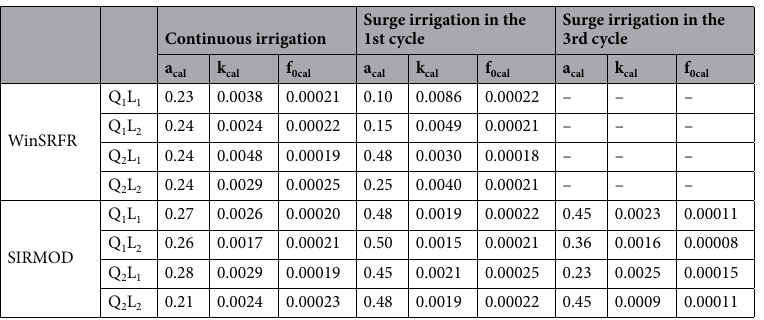
Table 4. Calibrated values of the non-conservatives infiltration parameters of the continuous and surge irrigations in WinSRFR and SIRMOD. Q: stream size; L: furrow length; R 0.5 : surge irrigation with cycle ratio of 0.5. k and a : empirical coefficients ( a :dimensionless, k : m 3 min −α m −1 ); f 0 basic infiltration rate (m 3 m −1 min −1